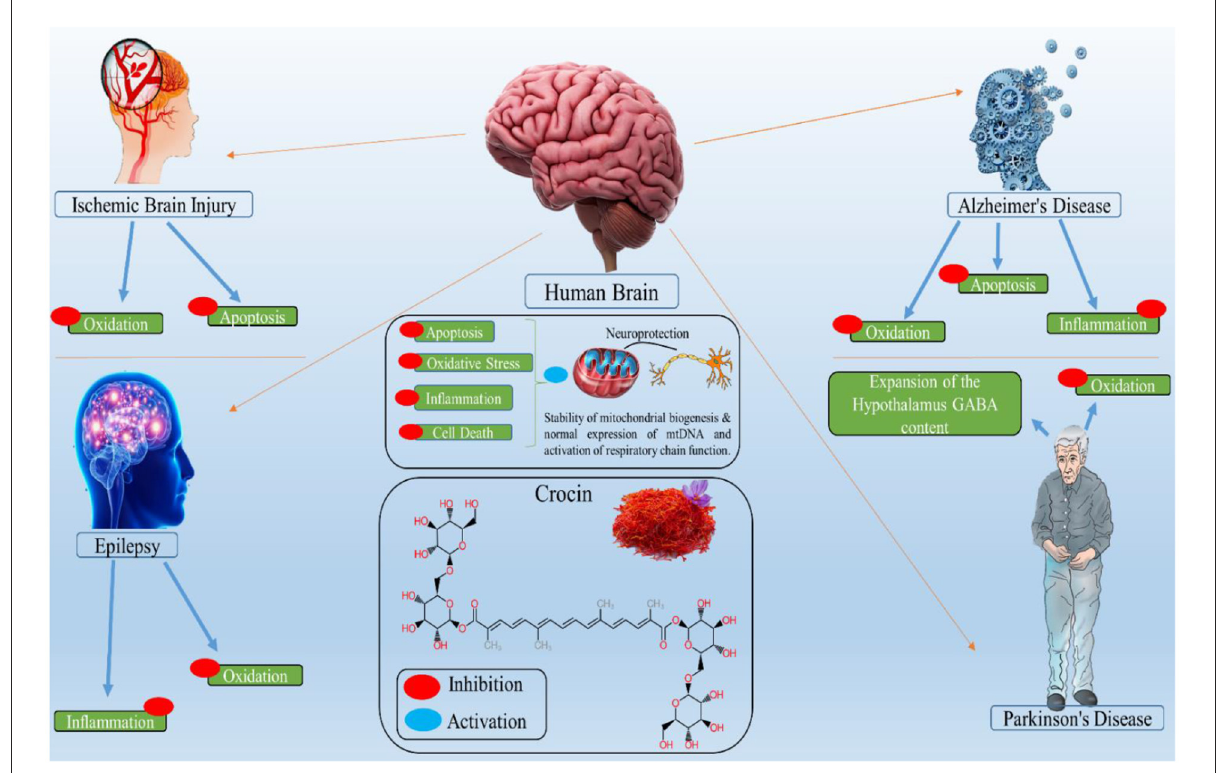
FIGURE2 Biological activity of crocin in different brain related disorders, where the red circle shows the inhibitory property of crocin and blue circle shows the activation.